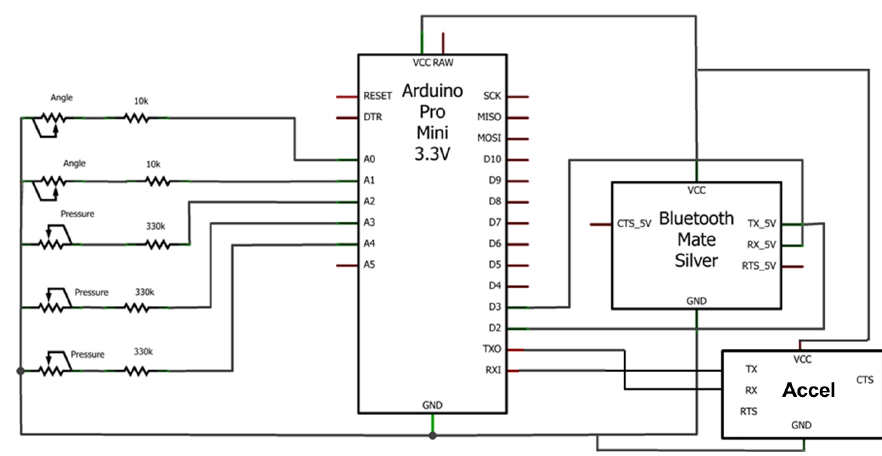
Figure 7. General circuit.